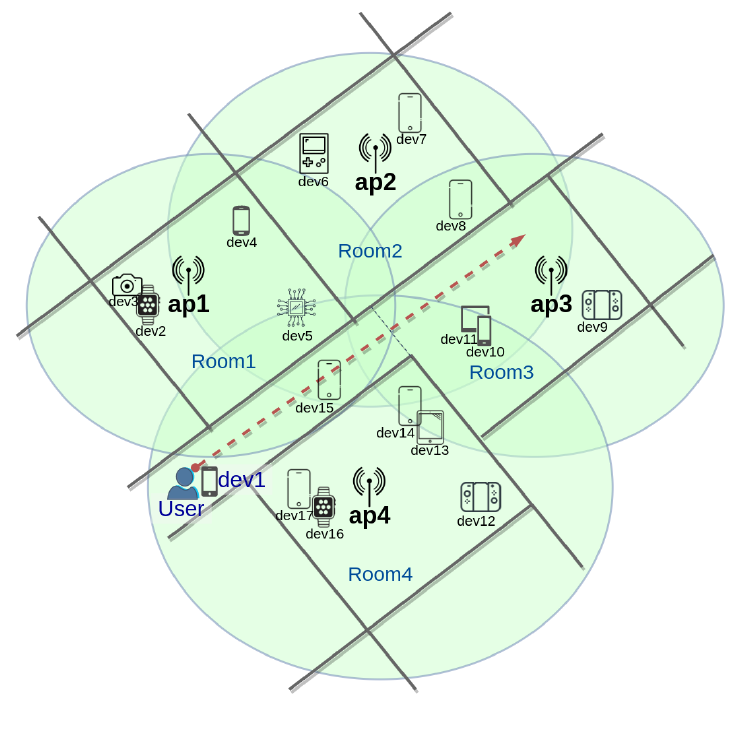
Figure 1. Motivation